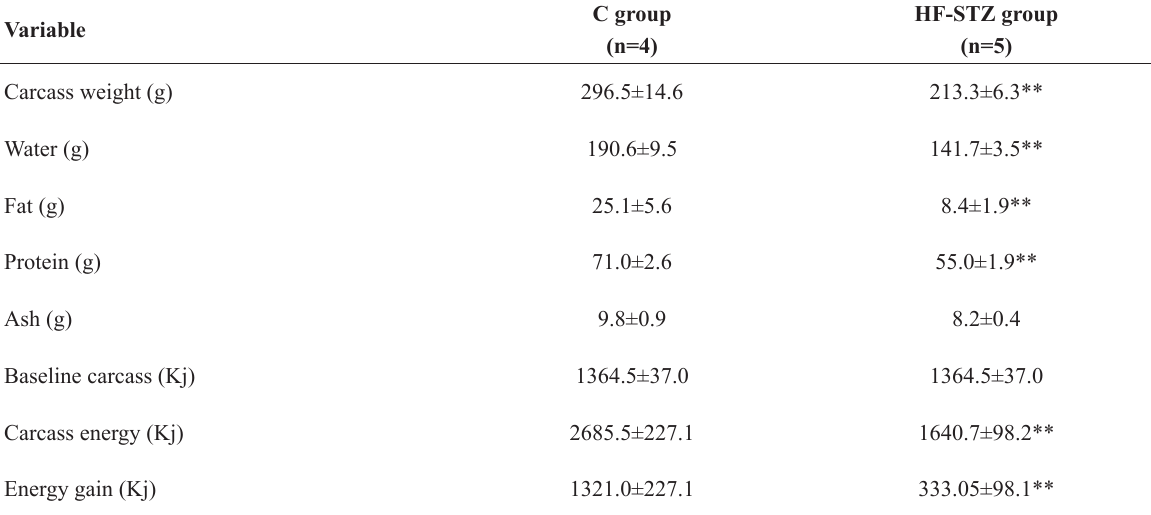
The carcass composition of male rats subjected to control diet (C) or high-fat diet/ streptozotocin (HF-STZ).